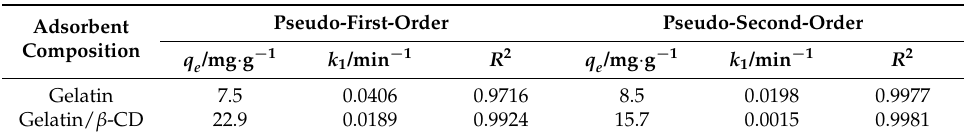
Figure 5. Adsorption kinetics of MB onto the gelatin and gelatin/ β -CD composite fiber adsorbents